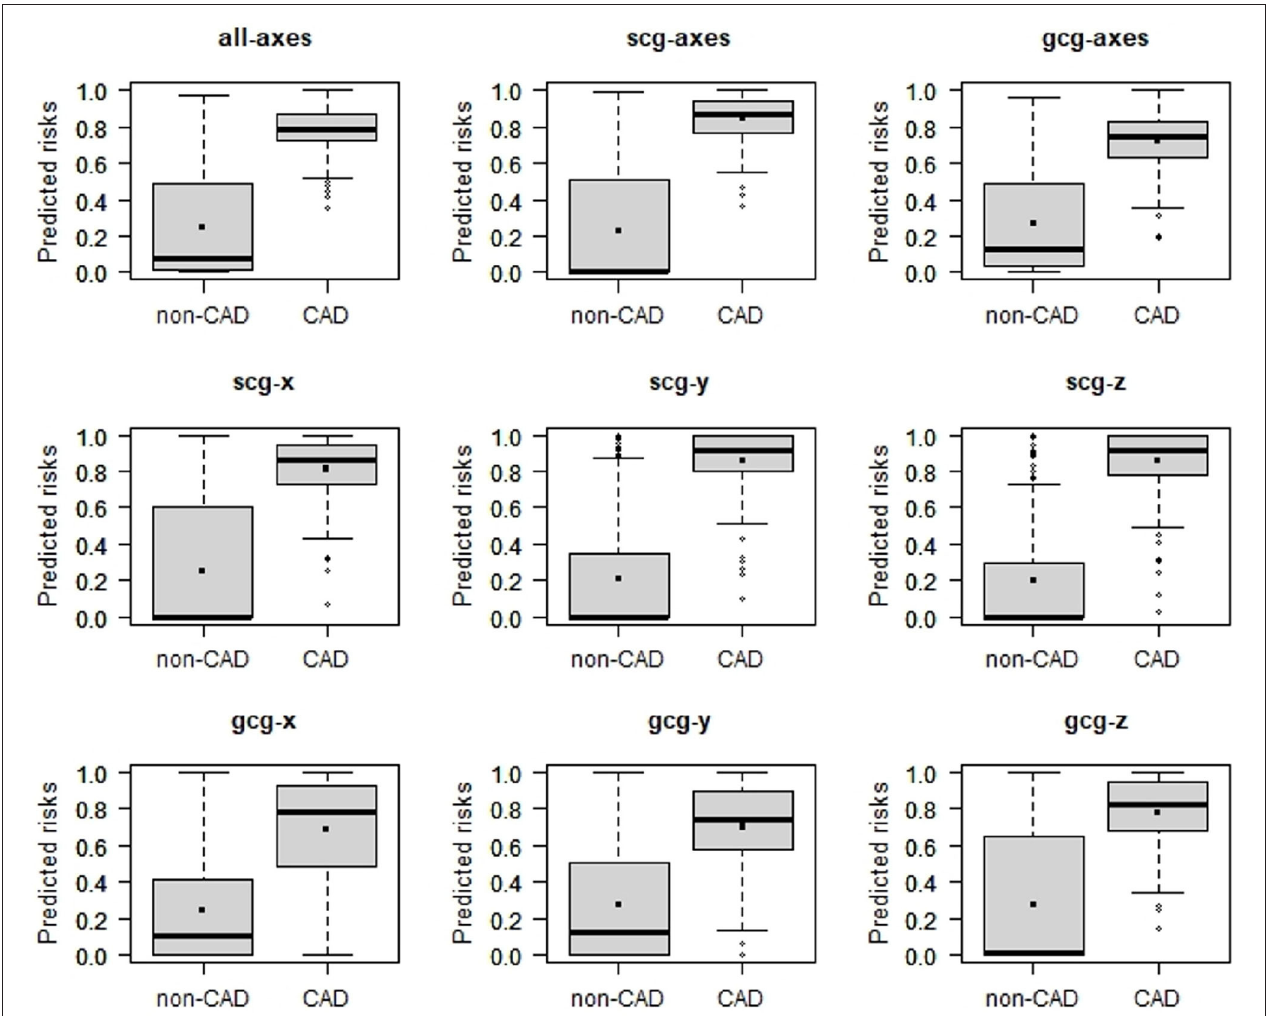
FIGURE 4 | Box plots of predicted risk of individuals with and without CAD estimated 6-channel model (CAD all _ axes ), the 3-channel SCG (CAD scg _ axes ), the 3-channel GCG (CAD gcg _ axes ), three one-channel SCG (CAD scg _ x , CAD scg _ y , CAD scg _ z ), and three one-channel GCG (CAD gcg _ x , CAD gcg _ y , CAD gcg _ z )